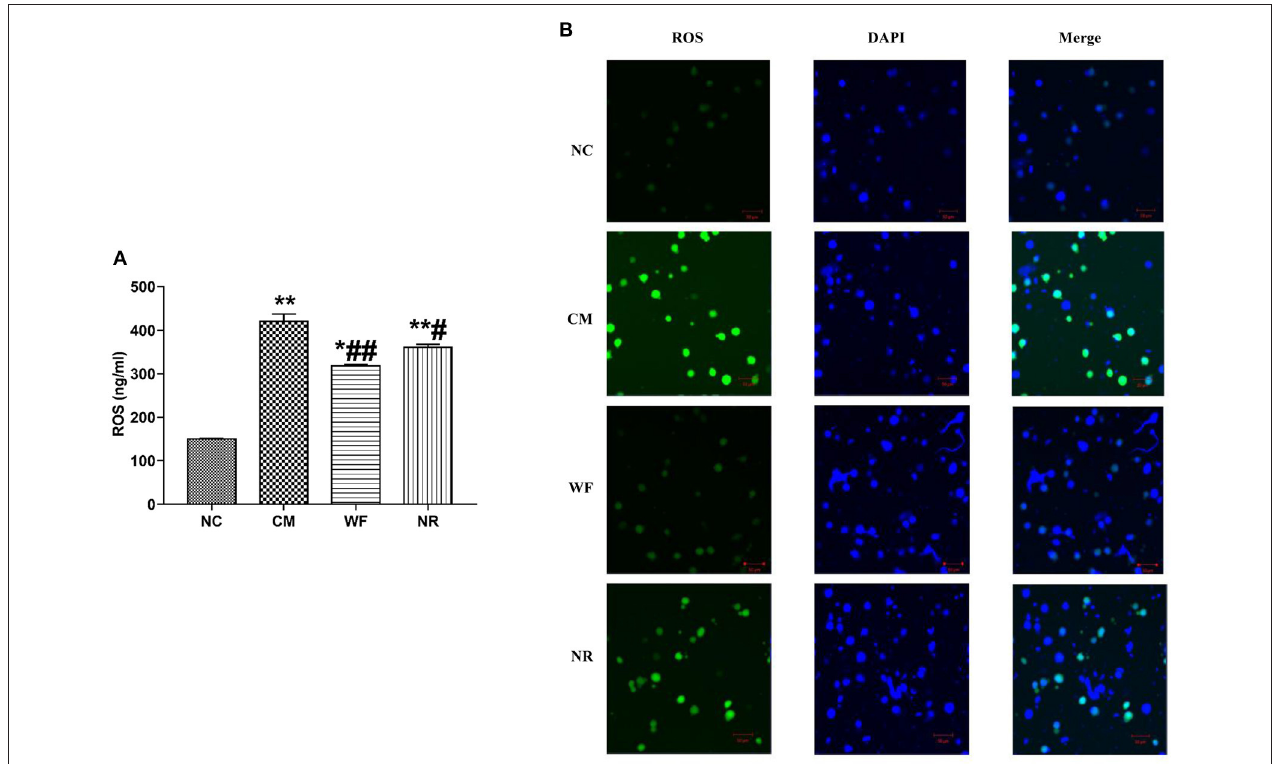
FIGURE 4 | Effects of the waterfall forest environment (WF) on the expression of reactive oxygen species (ROS). (A) Effects of the WF on the expression of ROS in serum of rats. * p < 0.05 and ** p < 0.01 vs. the normal control (NC) group. # p < 0.05 and ## p < 0.01 vs. the chronic stress model (CM) group. (B) Effects of the WF on the expression of ROS in liver tissues of rats. The production of ROS in the liver tissues was detected by using dichlorofluorescein diacetate (DCFH-DA). Scale bars are 50 µ